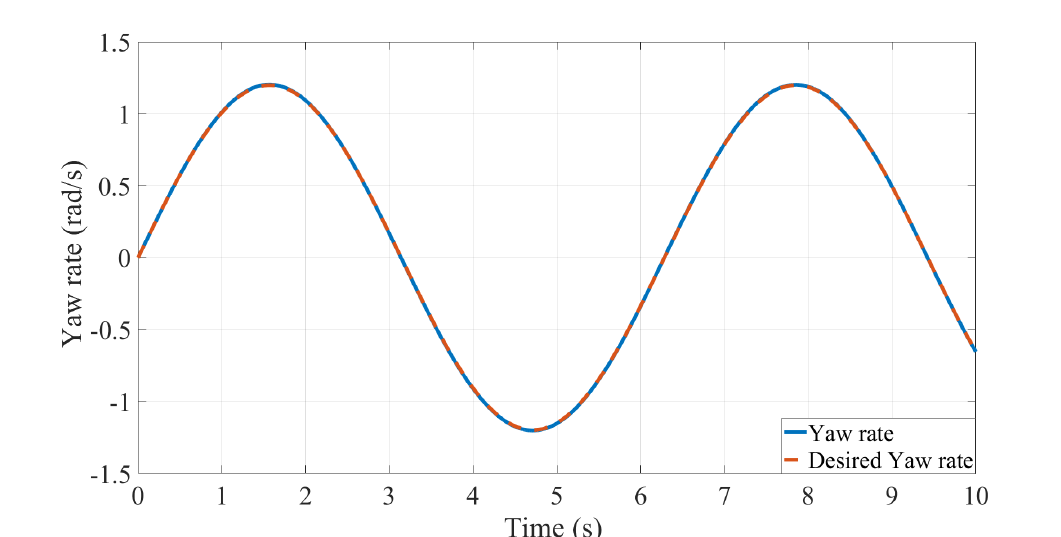
Figure 12. Controlled yaw rates with disturbance with constant input.